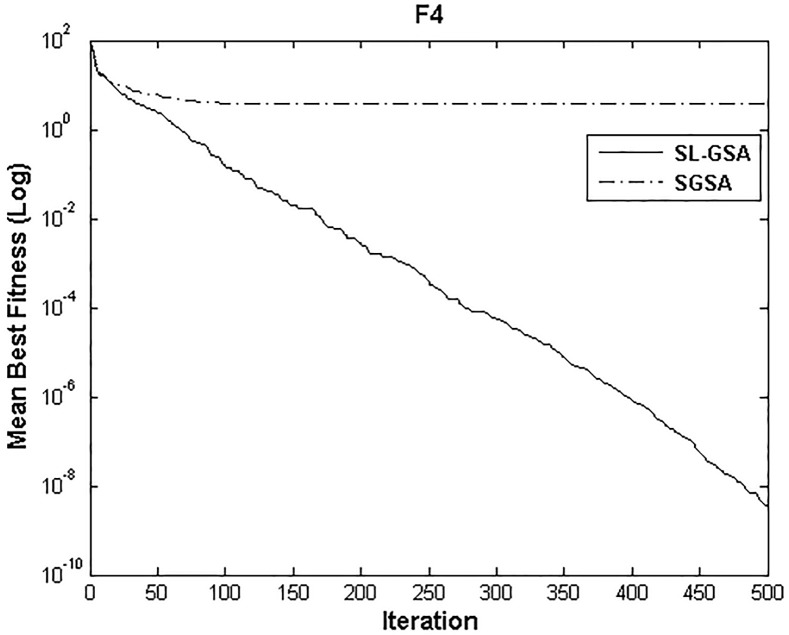
Performance comparison of SGSA and SL-GSA for minimization of F4.